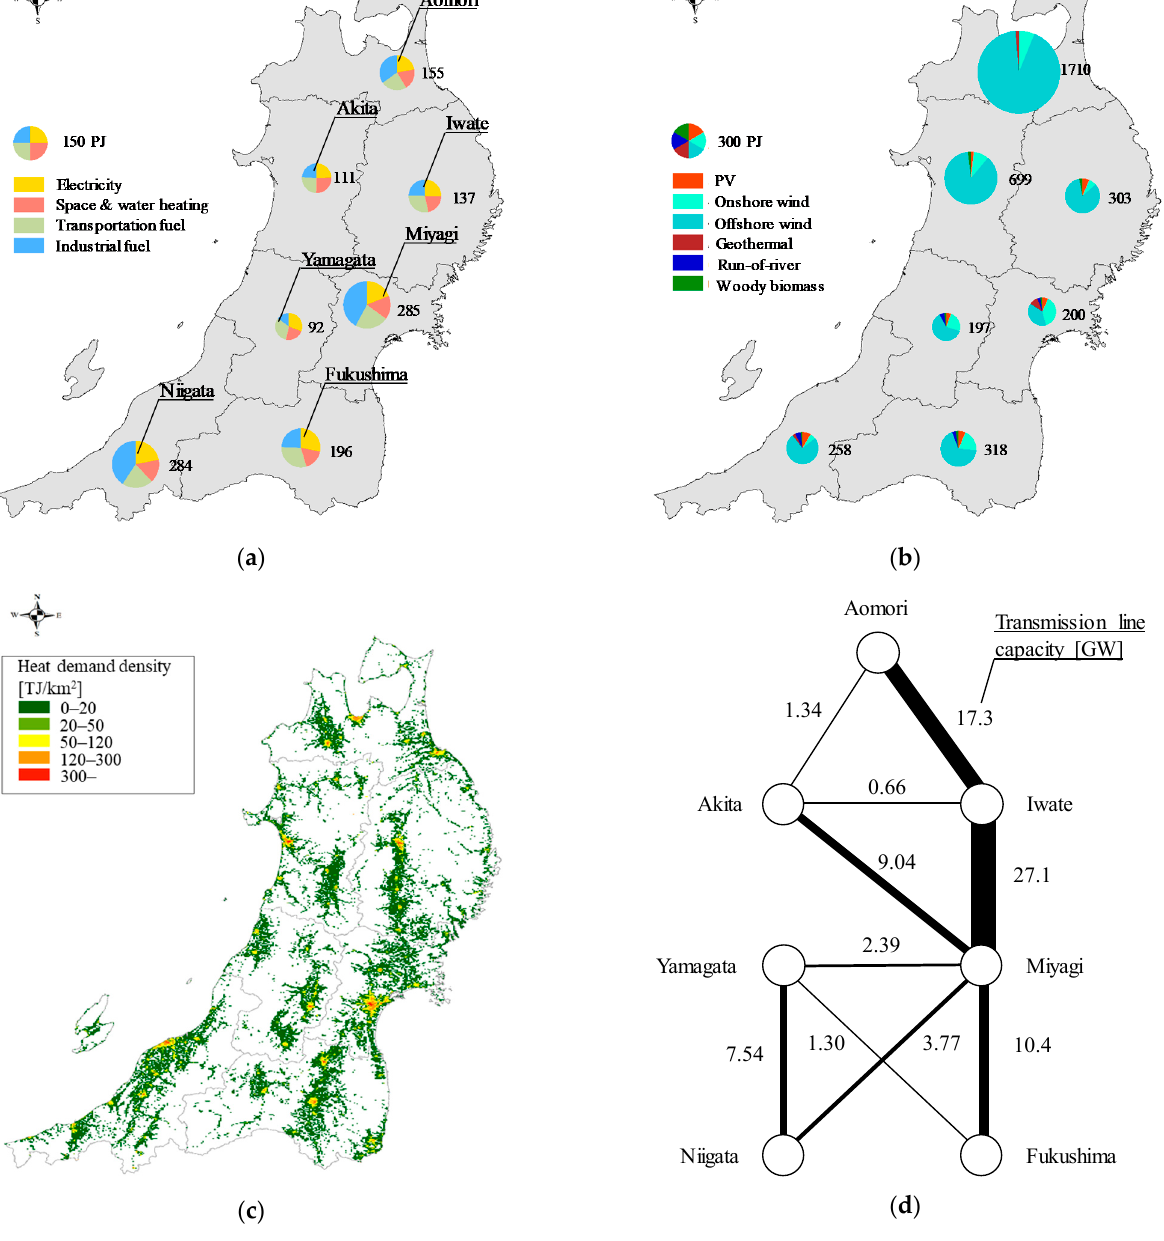
Figure 2. Spatial information of energy system in Tohoku region. ( a ) Energy demands. ( b ) Renewable energy potential. ( c ) Heat demand density map. ( d ) Modeled electrical grid. Table 1. Tank-to-wheel efficiency of each type of vehicle [kWh/km].